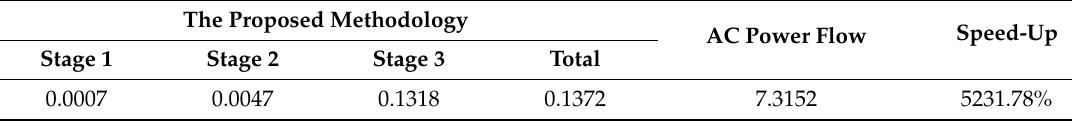
Table 4. CPU time required for the example